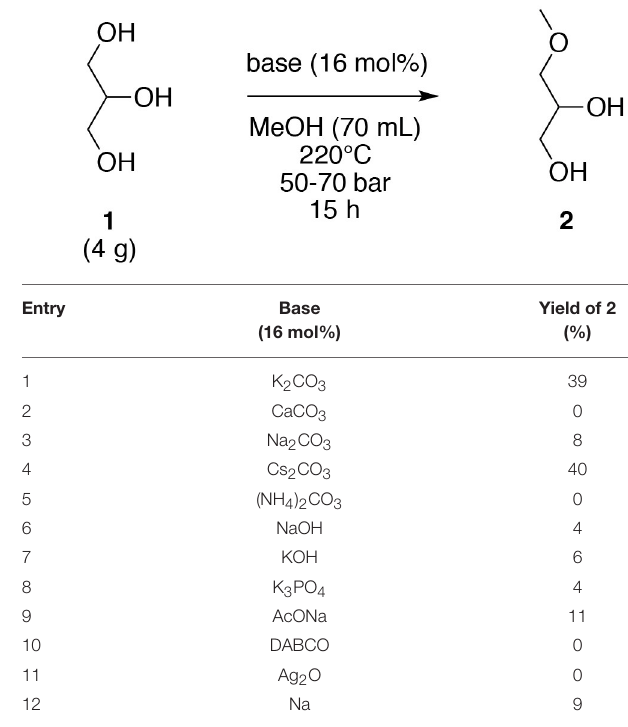
TABLE 2 | Variation of the nature of the base for the O -methylation of glycerol ( 1 ) in subcritical